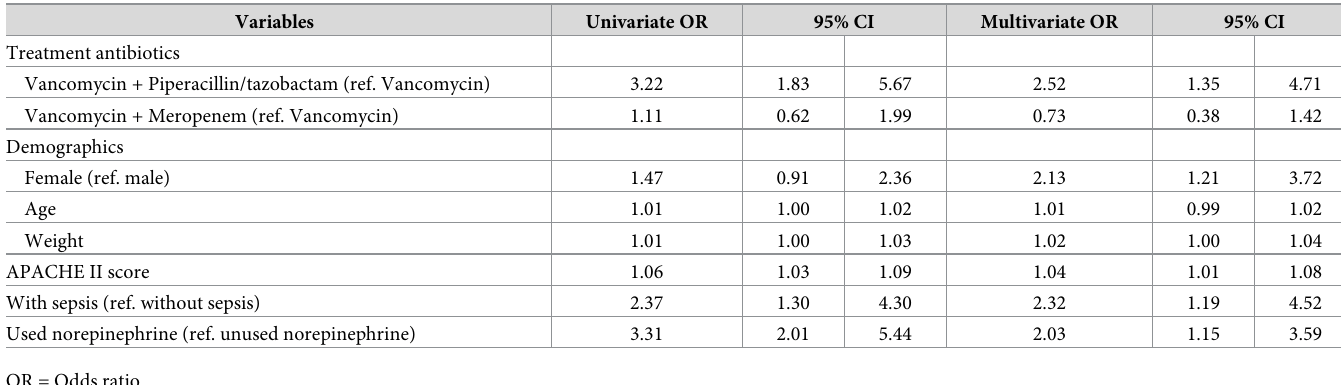
Table 4. Effective factors for development of